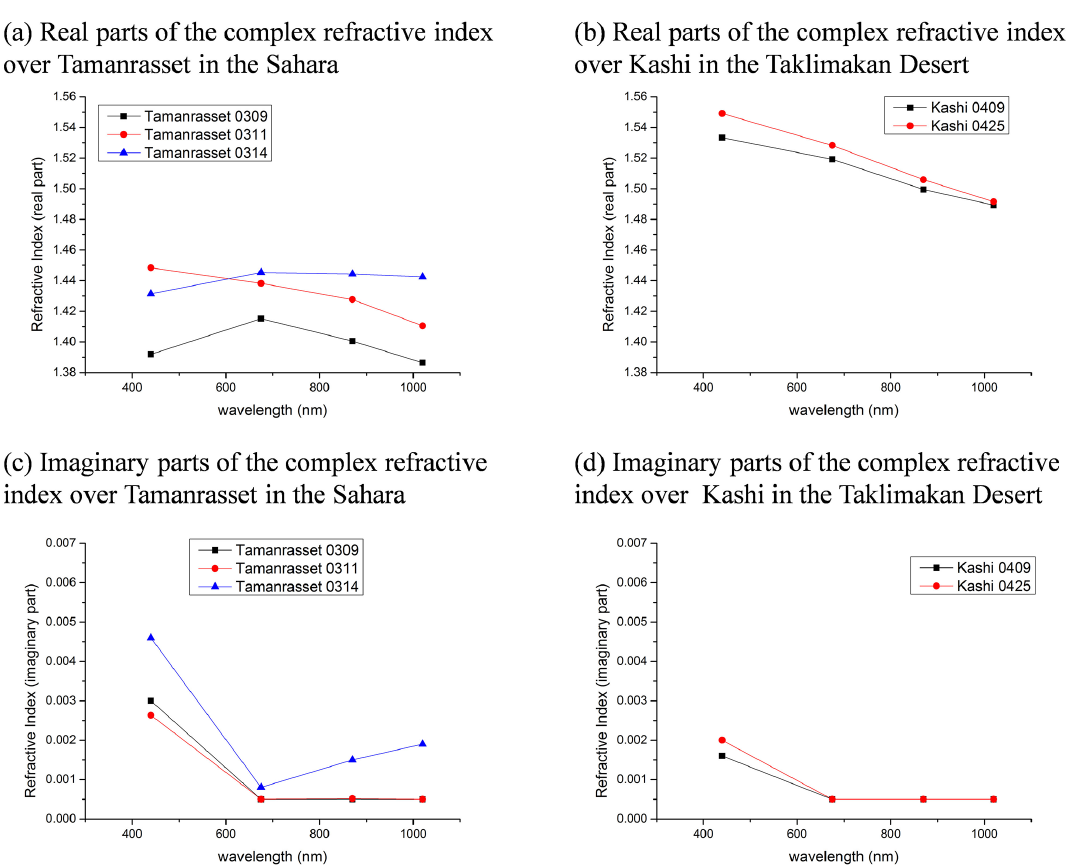
Figure 11. Real and imaginary parts of the dust complex refractive index over Tamanrasset in the Sahara and Kashi in the Taklimakan Desert.